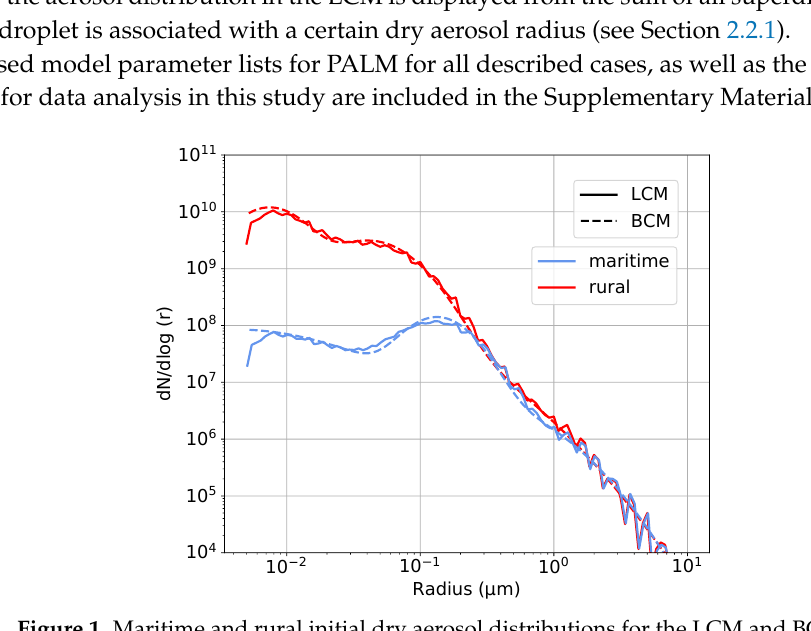
Figure 1. Maritime and rural initial dry aerosol distributions for the LCM and